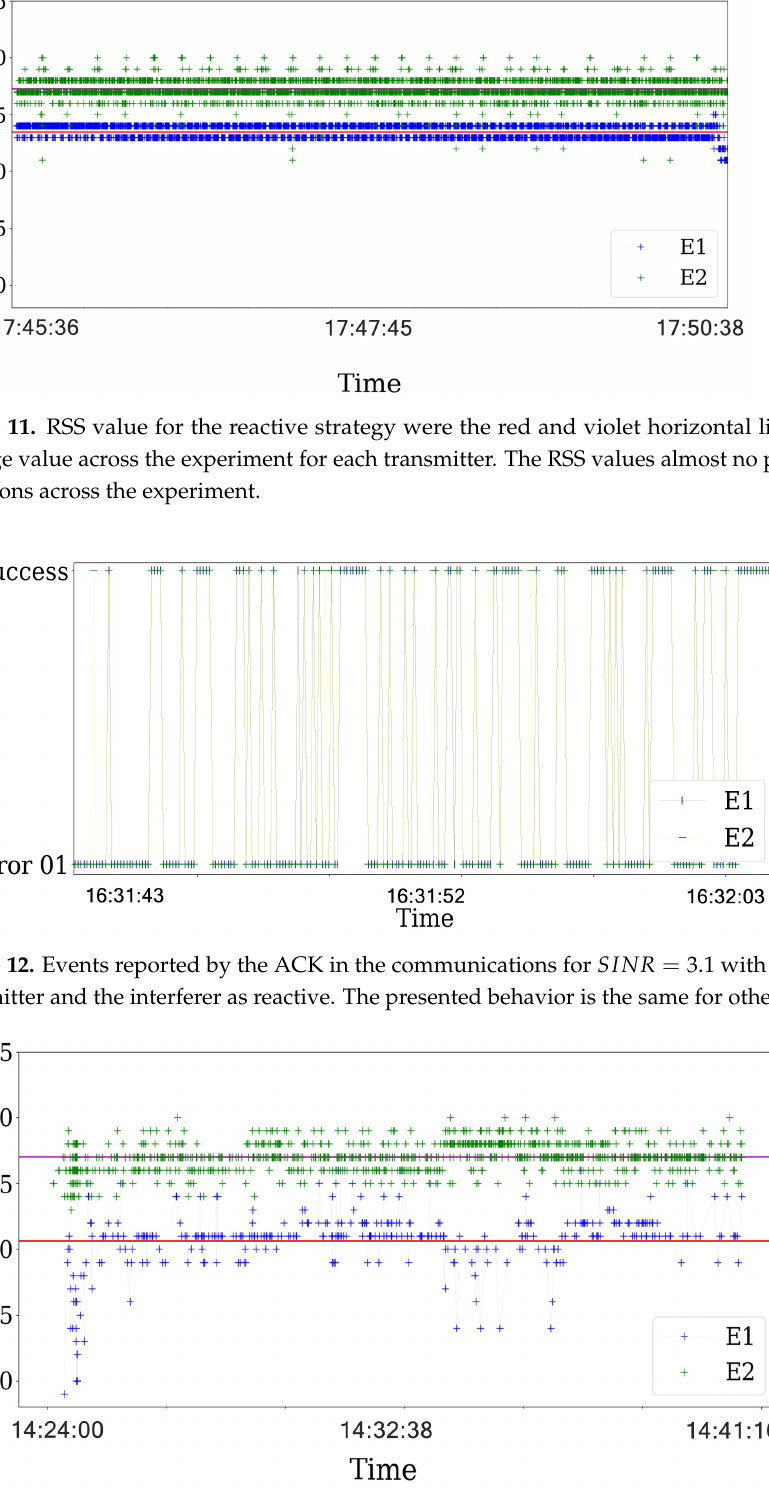
Figure 13. RSS value for the constant strategy were the red and violet horizontal lines shows the average value across the experiment for each transmitter. The RSS values presents a higher variance than the reactive